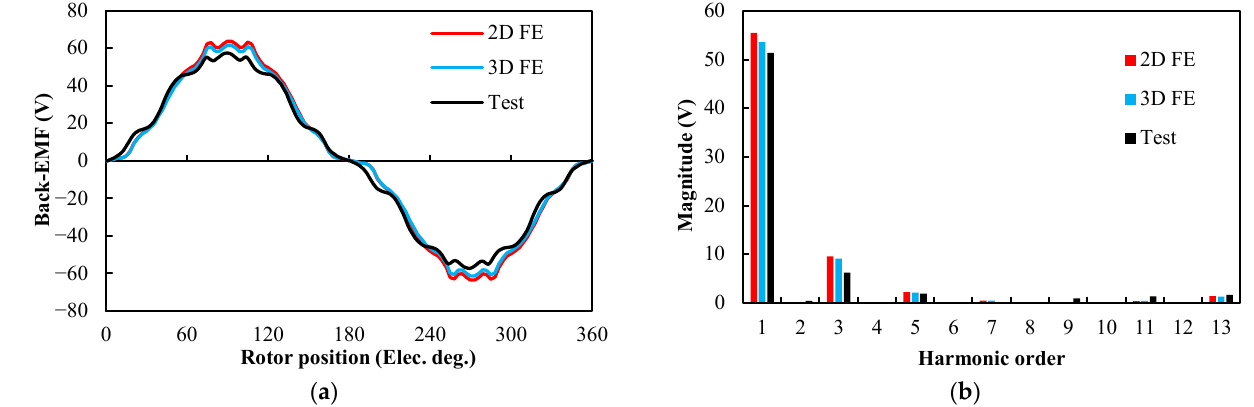
Figure 41. Phase back EMF comparison between FE and measured results at 1000 rpm: ( a ) waveforms; ( b ) spectra.